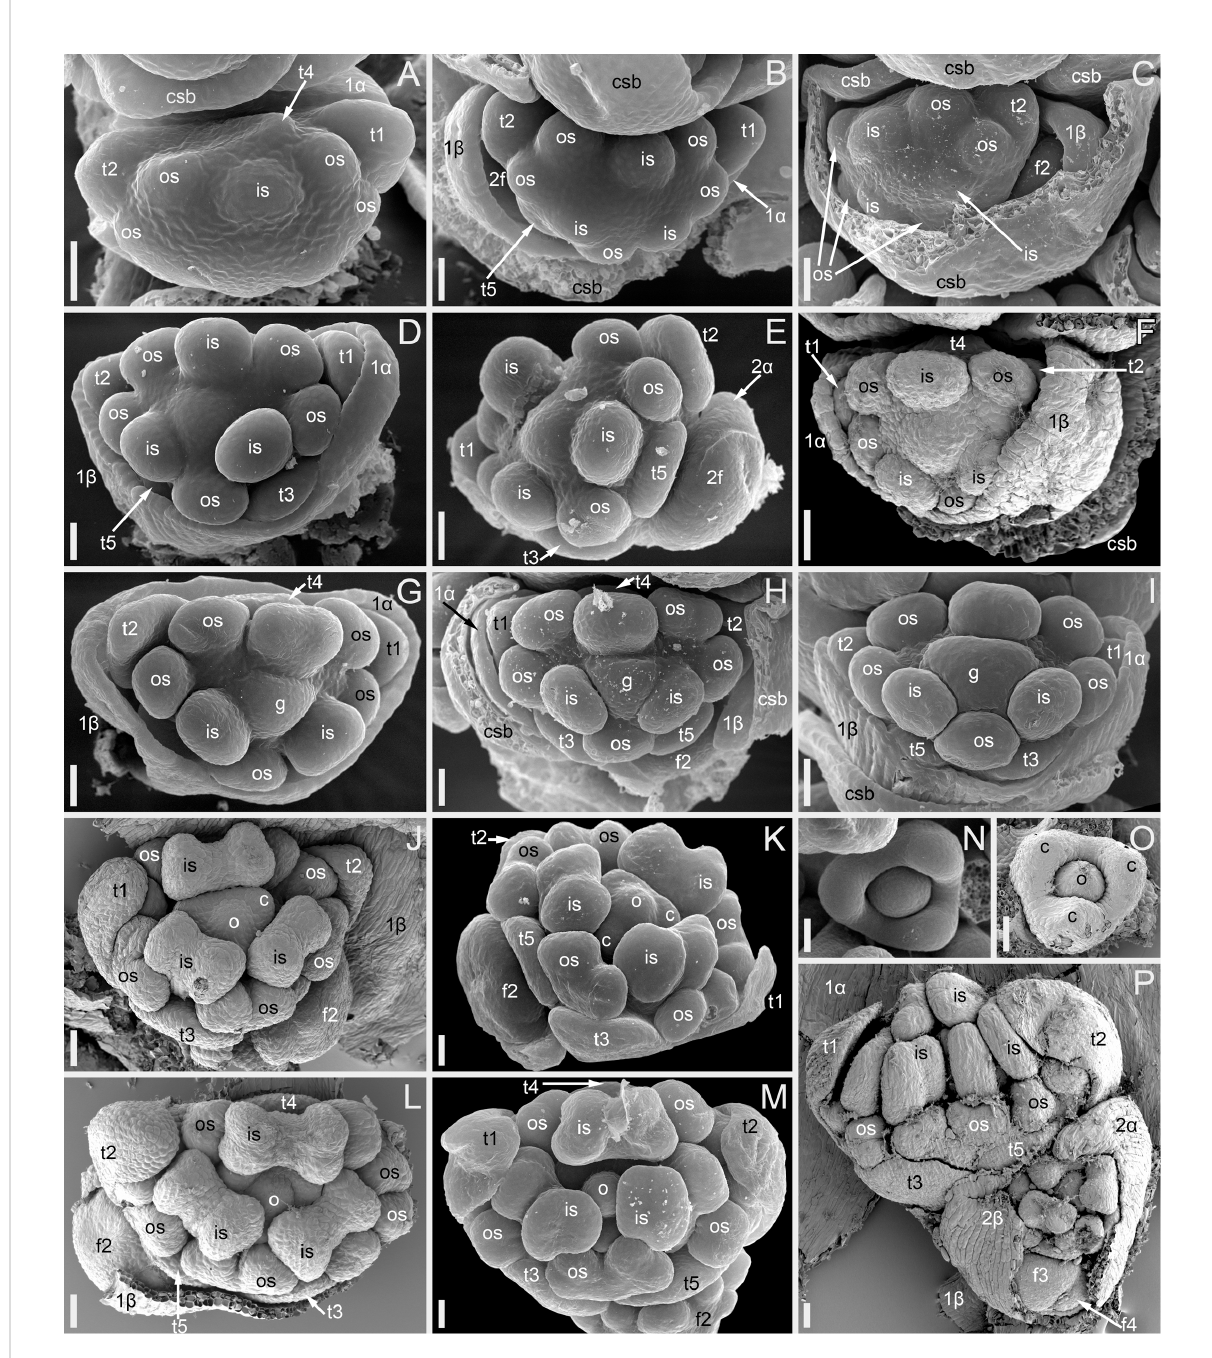
FIGURE 3 Flower development in Fagopyrum esculentum , stages 5 – 9 (SEM). (A – C) Stage 5. (A) Adaxial view of cyme with subtending bract removed and prophyllar sheath partly removed. Subtending bract of a younger cyme is visible and its imprint can be recognized between t2 and t4. The pressure made t4 asymmetric. (B, C) Two mirror-shaped cymes with subtending bracts partly removed. (D – F) Stage 6. The prophyllar sheath is removed in (E) . (G – I) Stage 7. The prophyllar sheath is partly dissected in (H) . (J, K) Stage 8. The prophyllar sheath is dissected in (J) and removed in (K) . (L, M) Stage 9. The prophyllar sheath is dissected in (L) and removed in (M) . (J) and (M) are mirror-shaped relative to (K) and (L) . (N, O) Gynoecia of fl ower in Stage 9. (P) Four- fl owered cyme with fl owers at successive developmental stages. The prophyllar sheath of the fl ower 2 is dissected. (A, B, D, E, G, N) FAD_F2_2018. (C, H) Temp. (F, J, L, O, P) Dasha. (I, K, M) Chatyr Tau. 1 a , 1 b , prophylls of the fi rst fl ower of a cyme; 2 a , 2 b , prophylls of the second fl ower of a cyme; c, carpel apex; csb, cyme-subtending bract; f2, f3, f4, the second, the third and the fourth fl ower of a cyme; g, gynoecium; is, inner whorl stamen; o, ovule; os, outer whorl stamen; t1-t5, tepals in in order of their inferred (pre) patterning. Scale bars = 30 µm (A – P)